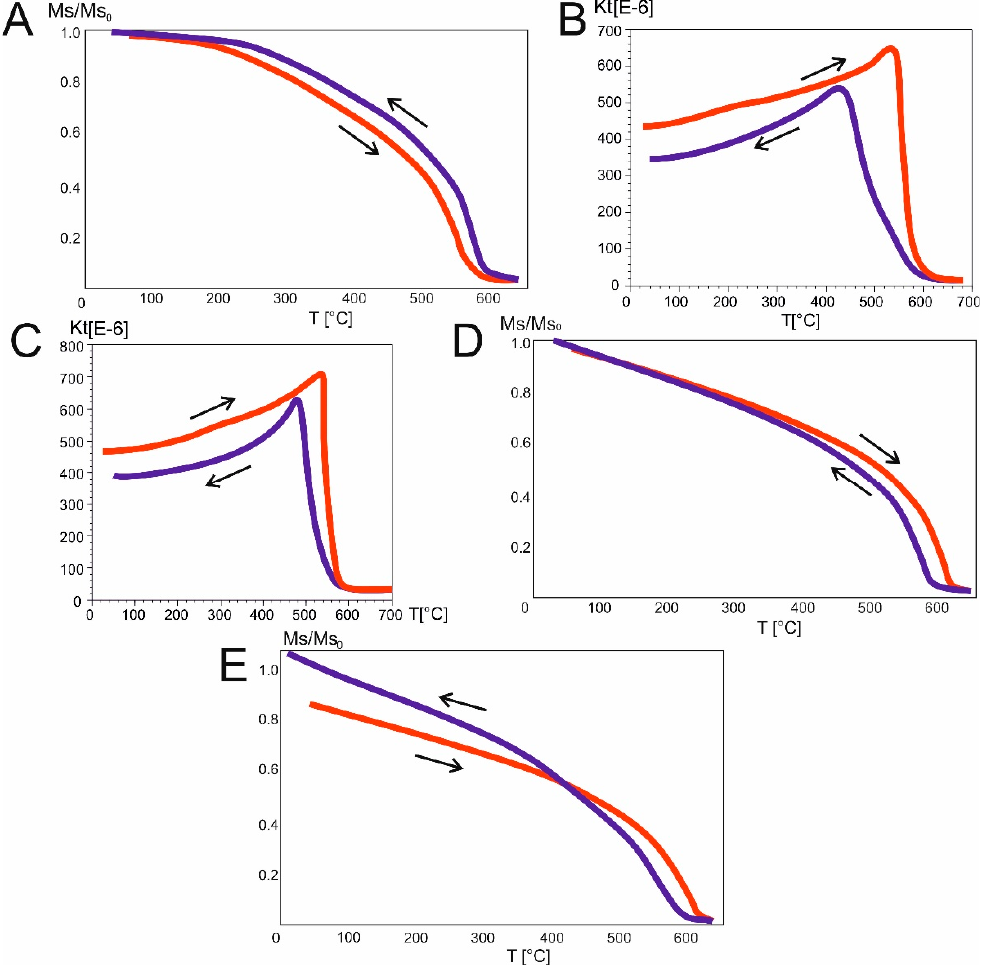
Figure 3. Rock magnetic properties. ( A , D , E )—thermal dependences of saturation magnetization. ( A )—sample 130, site on31, Onkuchaksky Formation. ( D )—sample 432, site tv3, Tyvankitsky Formation. ( E )—sample 733, location 8, Upper Delkansky Formation. ( B , C )—thermal dependences of magnetic susceptibiblity. ( B )—sample 161, site on39 , Onkuchaksky Formation. ( C )—sample 40, site on10 , Onkuchaksky Formation.